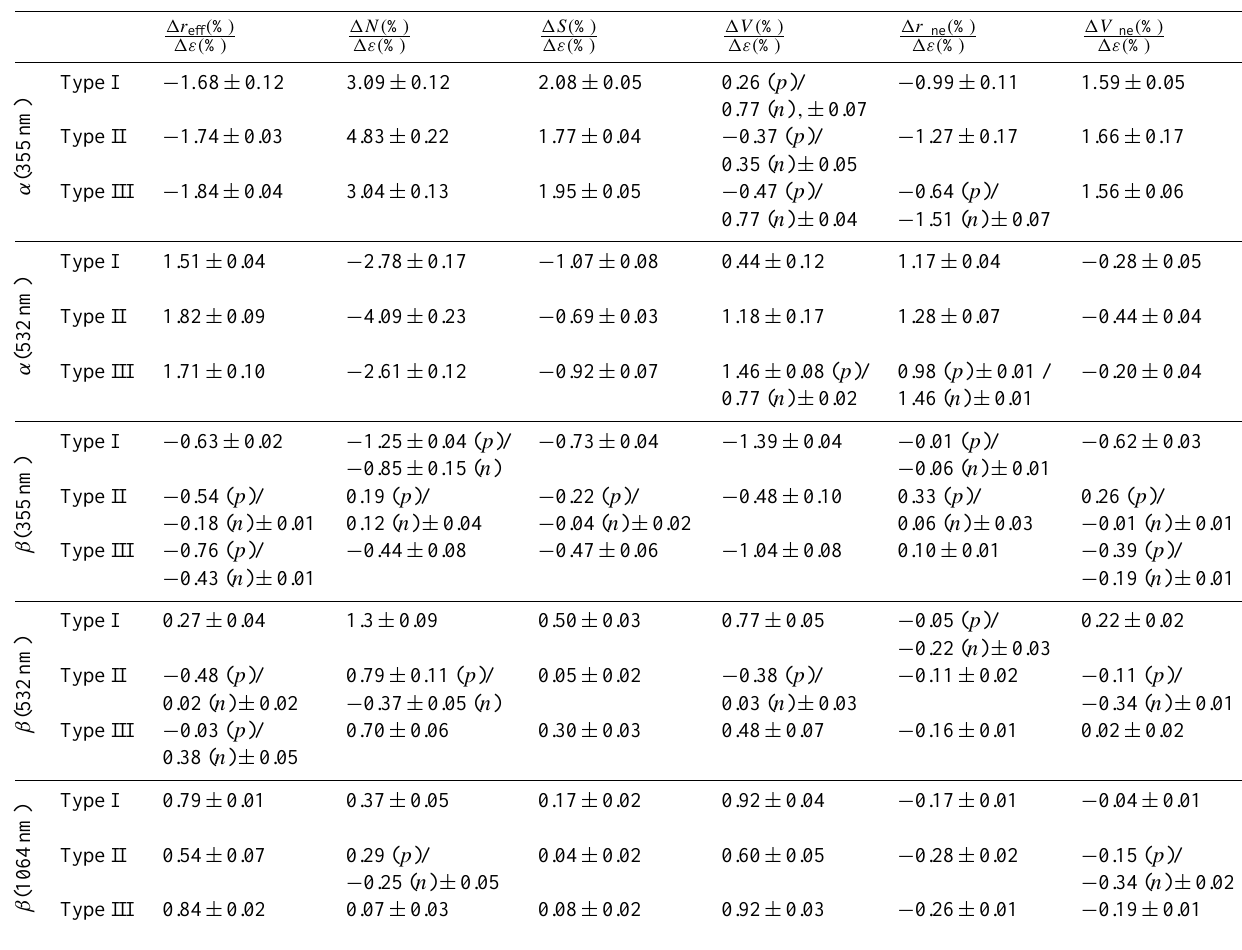
Table 1. Percentage deviations in the aerosol microphysical properties as a function of systematic errors in the optical data ε . Particularly, the slopes a of the linear fits Y = aX are presented, where X is the systematic bias in the optical data and Y is the corresponding deviation in the microphysical properties. All these fits presented linear determination coefficient R 2 >0.90. For the cases when there is a difference in slope between positive and negative biases in the input data, the slopes relating to the positive biases are indicated by ( p ), while those associated with negative biases are indicated by ( n